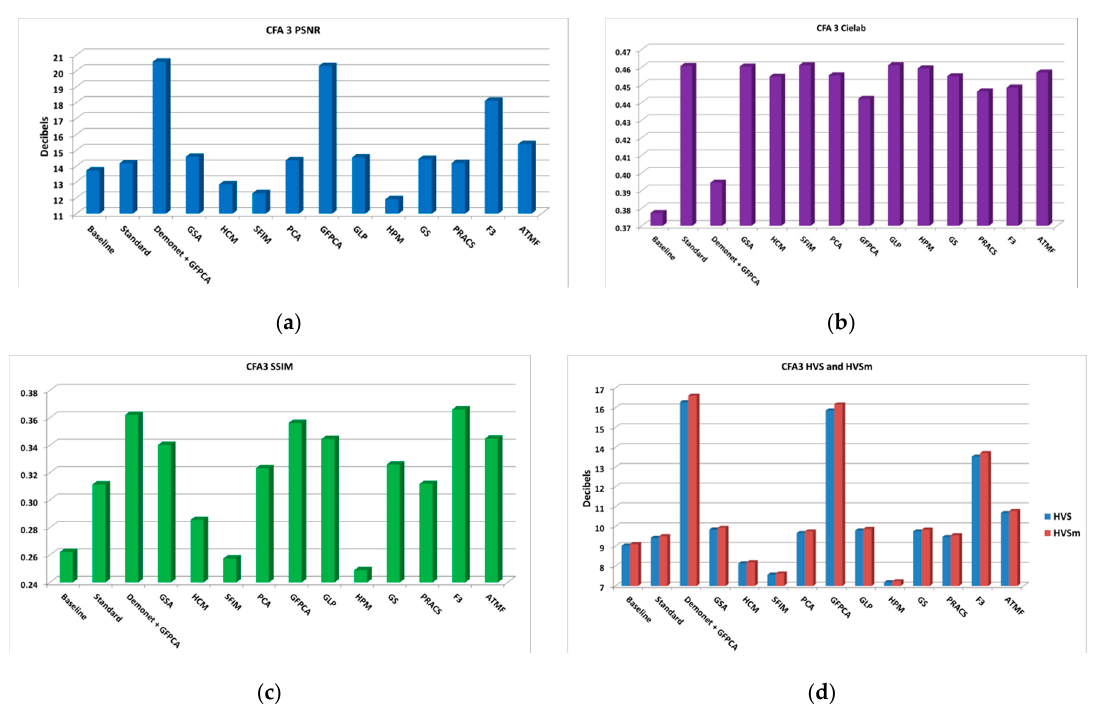
Figure 10. Averaged performance metrics for all the low light images at 10 dBs SNR (Poisson noise). ( a ) PNSR; ( b ) CIELAB; ( c ) SSIM; ( d ) HVS and HVSm.